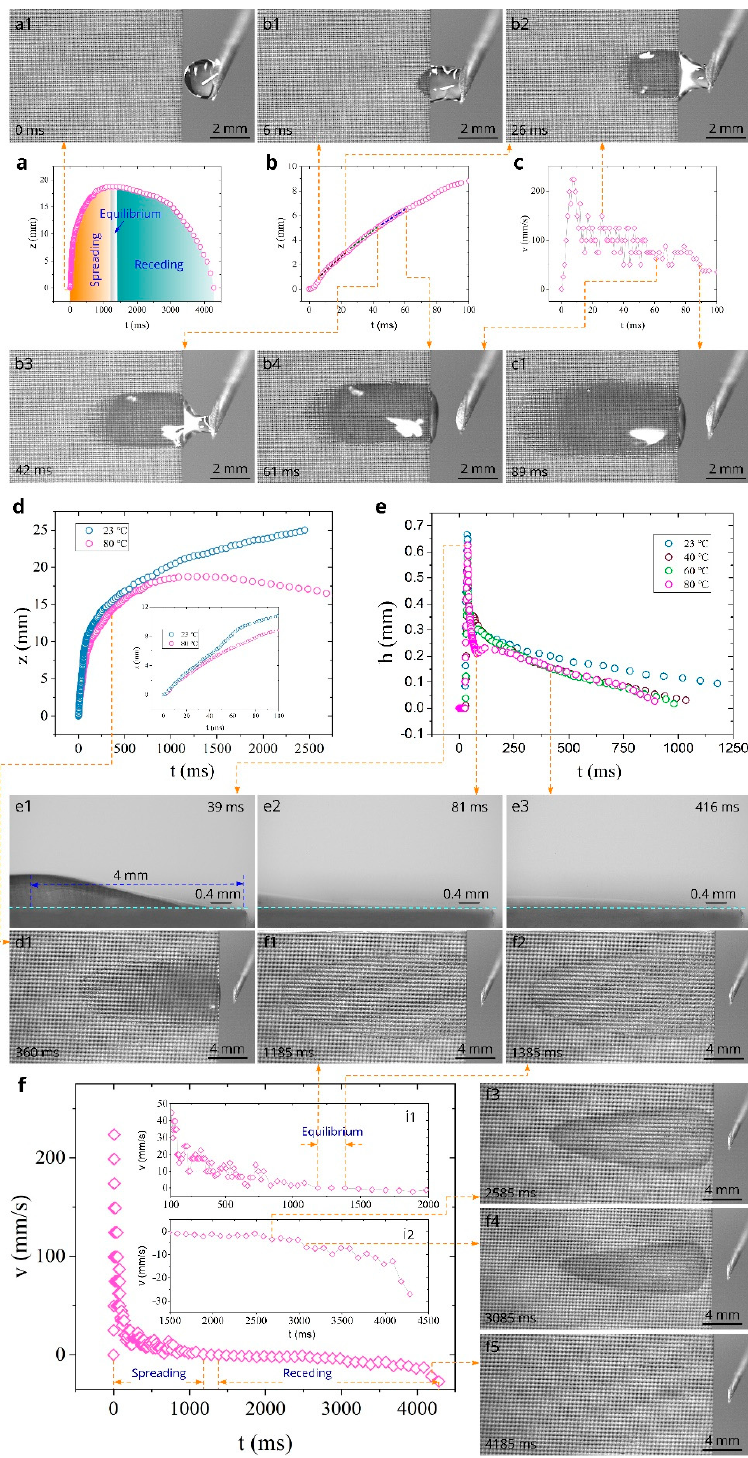
Figure 6. The z ( t ), v ( t ), and h ( t ) dependences at 80 °C and snapshots of water behaviors in spreading and receding regimes (experiment was performed 77 days after laser processing of the sample). ( a ) The overall plot of the spreading distance as a function of time. ( b ) Detailed z ( t ) plot in the time domain between 0 and 100 ms. The dashed lines show three z ∝ t substages. ( c ) Detailed plot of the spreading velocity as a function of time between 0 and 100 ms. ( d ) The comparison of z ( t ) dependences at 23 and 80 °C. ( e ) The comparison of h ( t ) dependences at the studied temperatures. ( f ) The overall plot of spreading and receding velocities as a function of time.